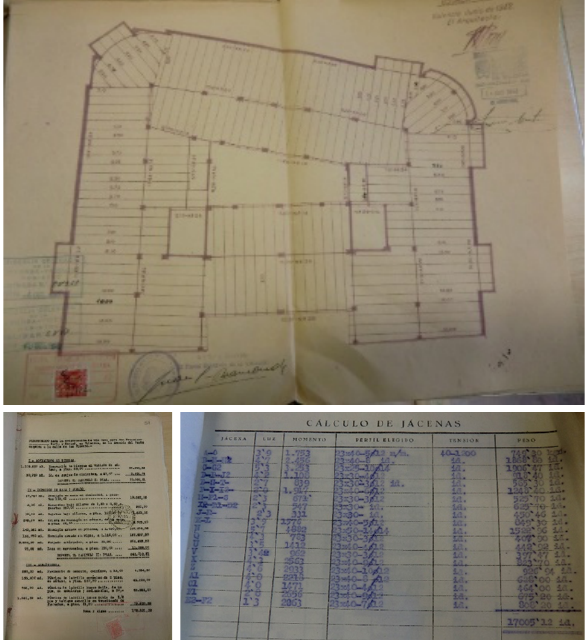
Figure 10. Example of a structure plan, budget and constructive report (Source: MHAV).